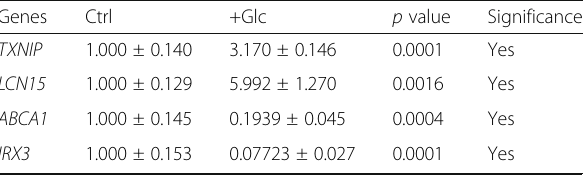
Table 6 Glucose-regulated mRNA levels of individual genes Genes Ctrl p